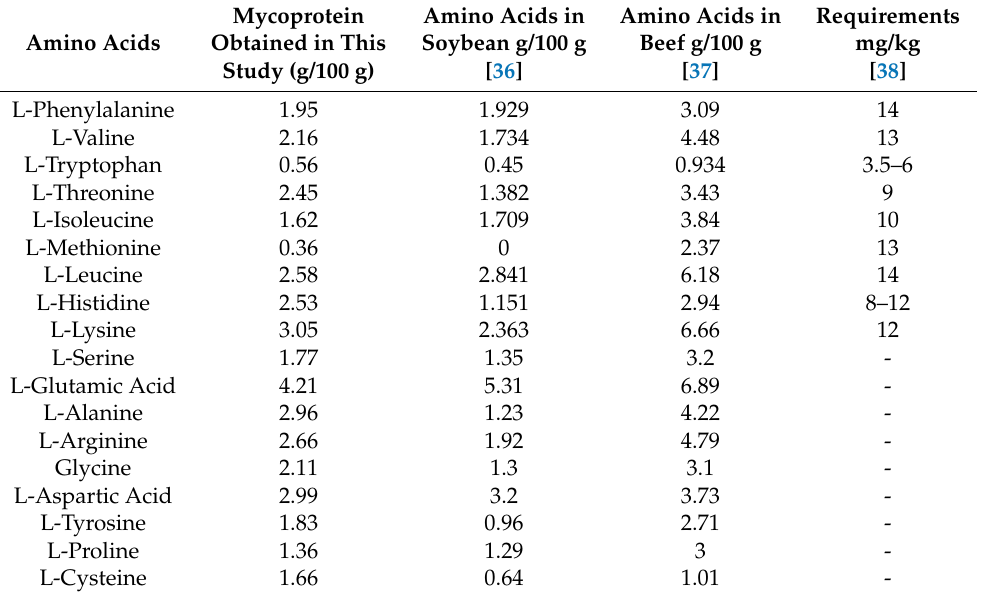
Table 3. Amino acid composition of mycoprotein, soybean, and beef and their requirement in the human